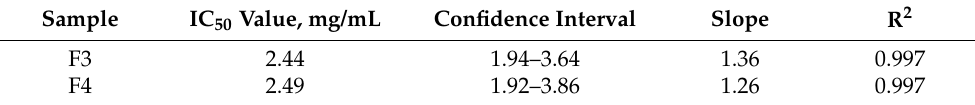
Table 5. Antioxidant activity of C. adhaerens fractions (F3 and F4) obtained using ABTS assay with corresponding IC 50 values and the significance parameters (confidence interval, slope and coeffi- cient of determination, R 2 ).